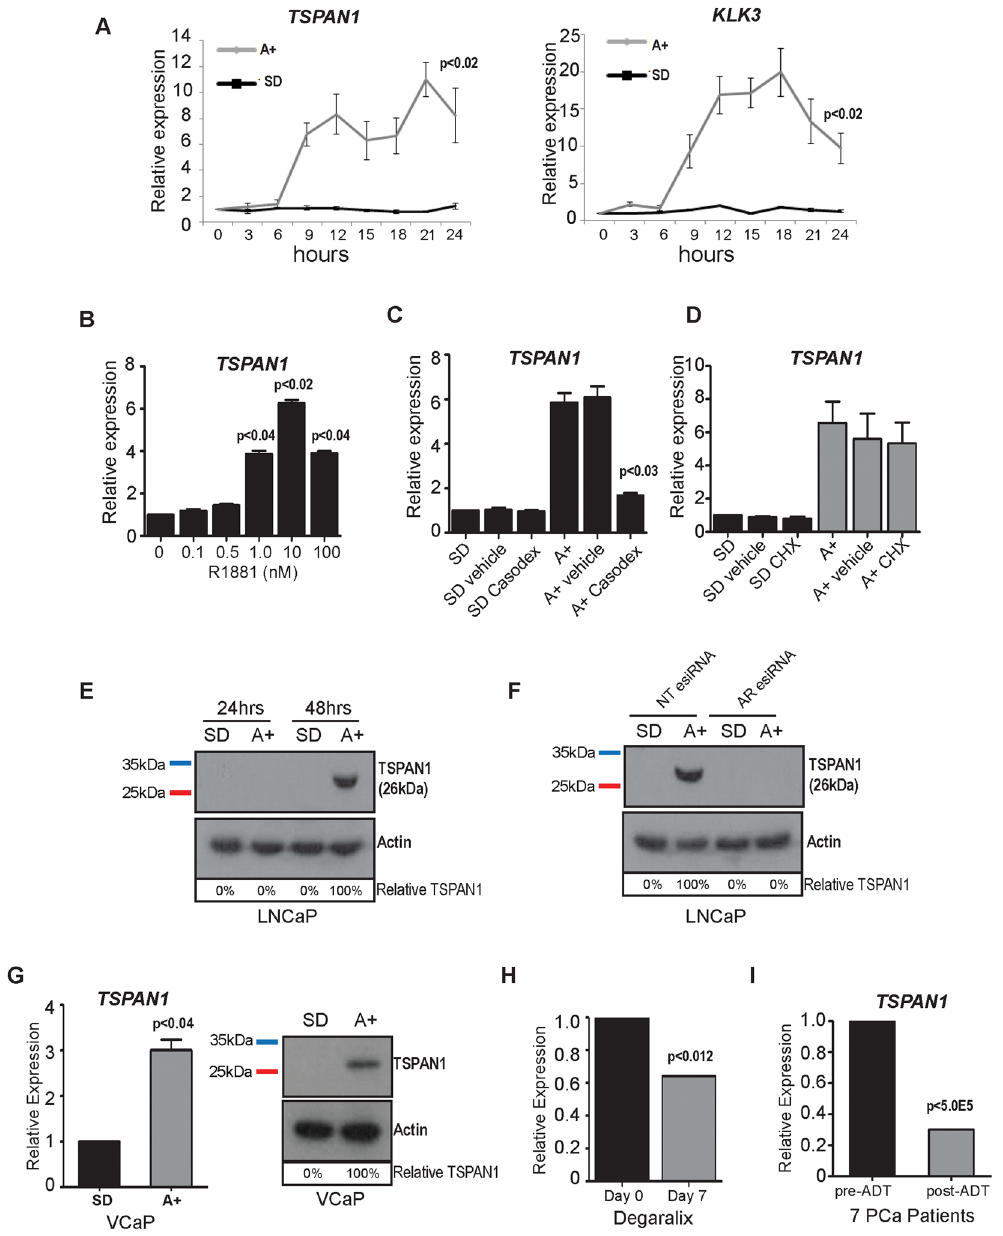
Figure 1. TSPAN1 is regulated by androgens in in vitro and in vivo . ( A ) Analysis of TSPAN1 and KLK3 (PSA) mRNA in LNCaP cells treated with androgens (A + ) over a 24 hour time course. ( B ) Upregulation of TSPAN1 is also evident in LNCaP cells treated with 1 to 100 nM of R1881. ( C ) Induction of TSPAN1 mRNA by the AR is inhibited in the presence of 10 μ M of the anti-androgen Casodex (bicalutamide) (lane 6). ( D ) The increase in TSPAN1 mRNA expression in response to androgens is still seen in the presence of 1 μ g/ml cycloheximide (CHX). Relative TSPAN1 expression was detected by real-time PCR and normalised to three reference genes. ( E ) Expression of TSPAN1 protein is induced in LNCaP cells treated with 10 nM R1881 for 48 hours as detected by western blot. Actin was used as a loading control. ( F ) Depletion of AR protein in LNCaP cells by esiRNA shows that when the AR is depleted there is no induction of the TSPAN1 protein in response to androgens. ( G ) Real-time PCR and western blot analysis of TSPAN1 mRNA and protein in VCaP cells grown in steroid deplete (SD) or 10 nM R1881 (androgens, A + ) treated conditions for 48 hours. ( H ) Analysis of TSPAN1 mRNA expression before and after 7 days of serum/tissue androgen depletion in prostate cancer patients using degarelix 31 . ( I ) Analysis of TSPAN1 expression in previously published RNA-Seq data 32 shows that TSPAN1 mRNA is significantly down-regulated in 7 PCa patients following androgen deprivation treatment (ADT). The Y axis shows the relative expression level of TSPAN1 (calculated by comparing the FPKM expression values of genes after ADT to the value before treatment). Please note: cropped western blots are displayed in the figure, but full length blots are included in the Supplementary Information